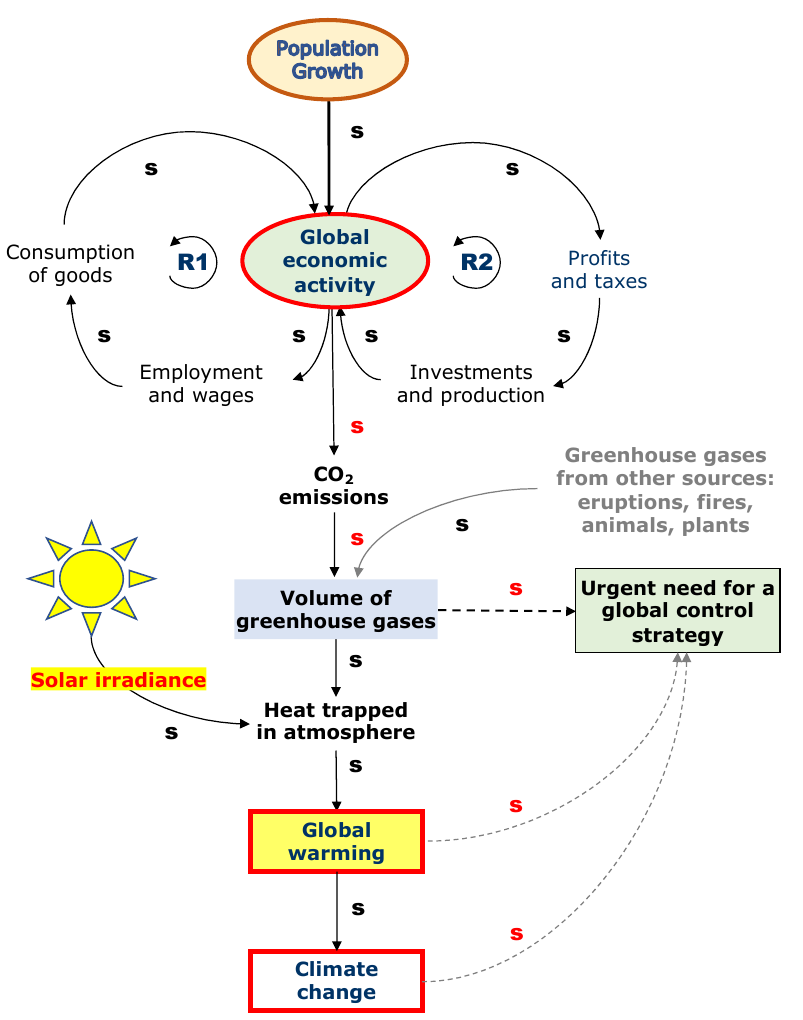
Figure 3. GEAM, Global Economic Activity Model, describing the system generating global warm- ing.